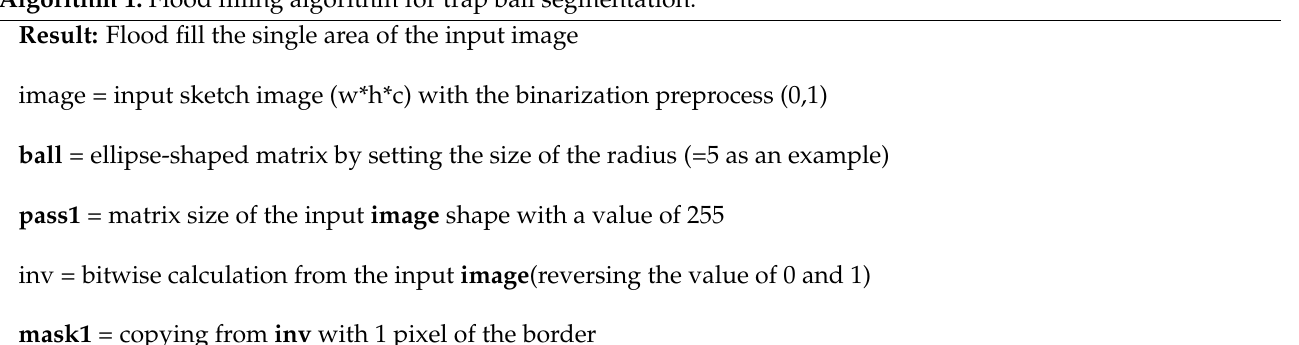
Algorithm 1: Flood filling algorithm for trap ball